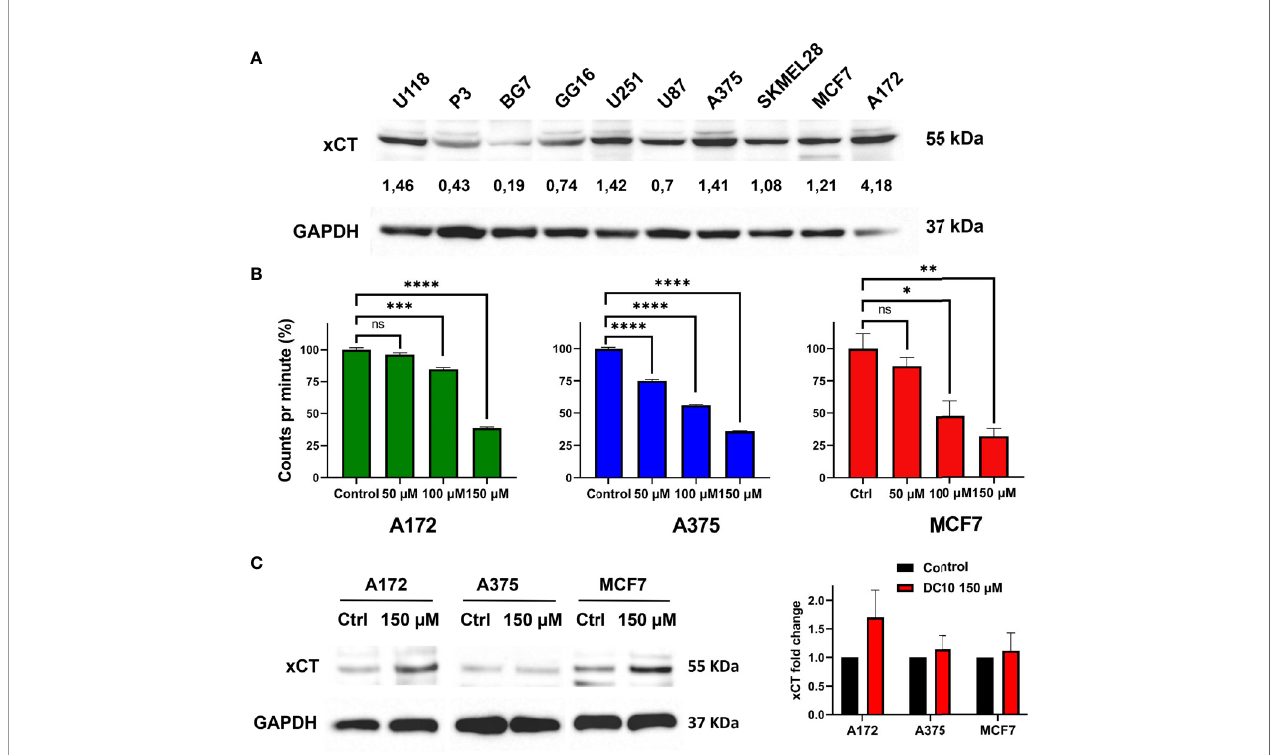
FIGURE 1 | DC10 inhibits cystine uptake in xCT expressing cancer cell lines. (A) Western blot for the xCT antiporter in a panel of cancer cell lines. GAPDH was used as a loading control. (B) [ 14 C] cystine uptake following treatment with 50 m M 100 m M and 150 m M doses of DC10 in the A172, A375 and MCF7 cell lines. (C) Western blots for xCT in the same cell lines in untreated and DC10 treated (left panel), with quanti fi cation of expression levels (right panel). *P < 0.05, **P < 0.01, ***P < 0.001, ****P < 0.0001. ns, not signi fi